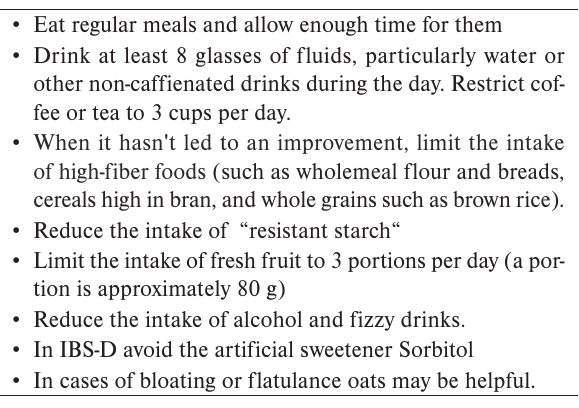
Table 4. Clinical Guidelines for modifying nutritional intake in IBS patients 11